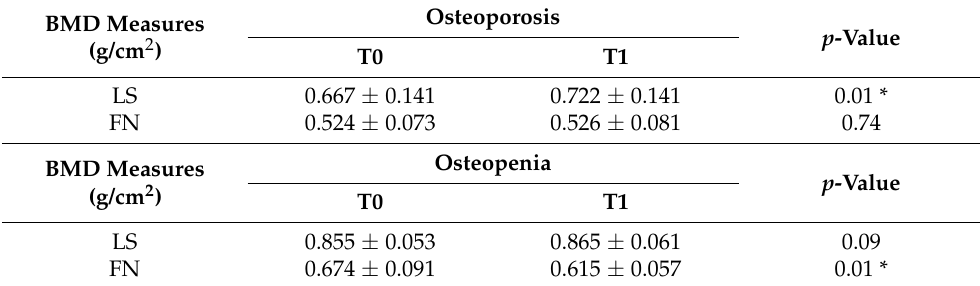
Table 2. Comparison of changes in absolute BMD after 12 months in each